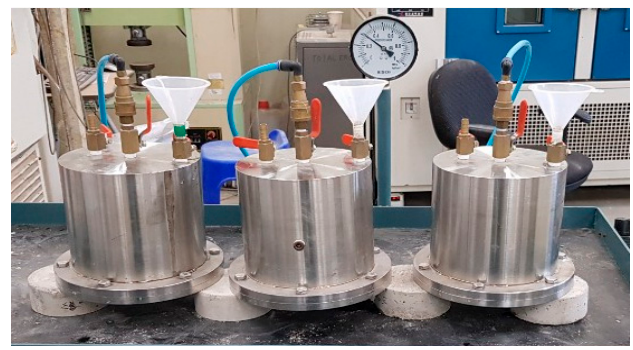
Figure 8. Water penetration test set-up.